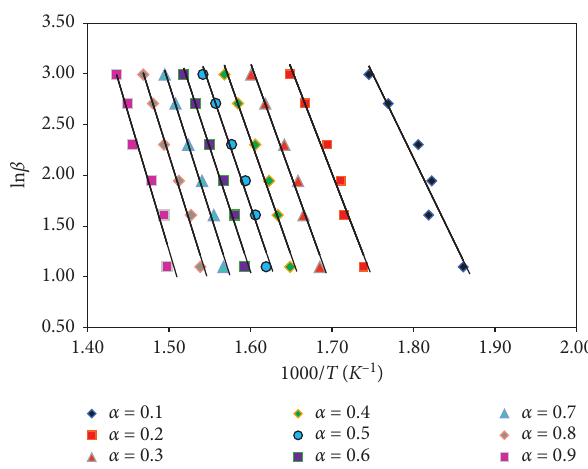
Figure 4: Kissinger plot ln ( β / T 2 PNVP- co -PHMA 60–40.